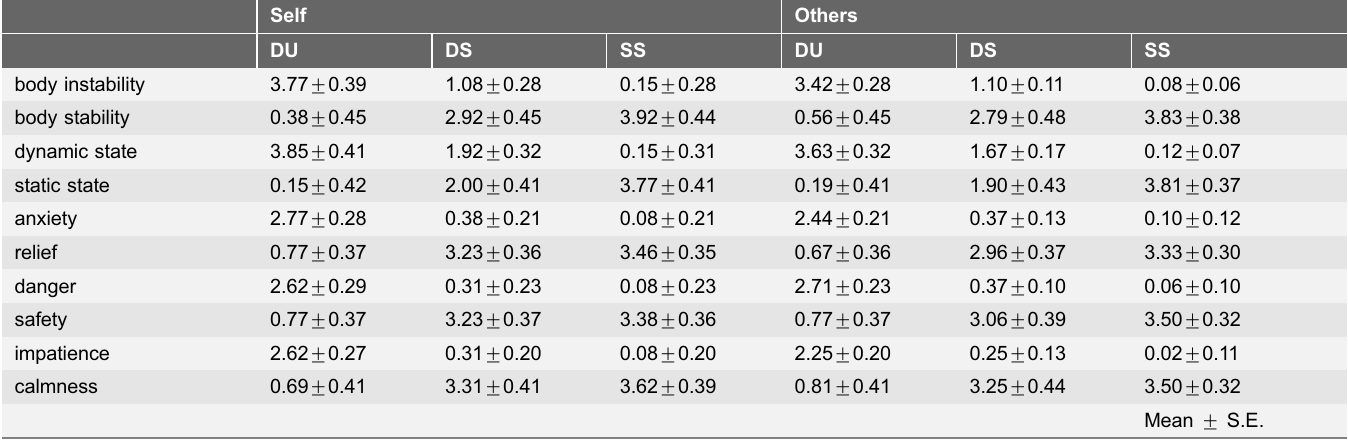
Table 1. Results of subjective